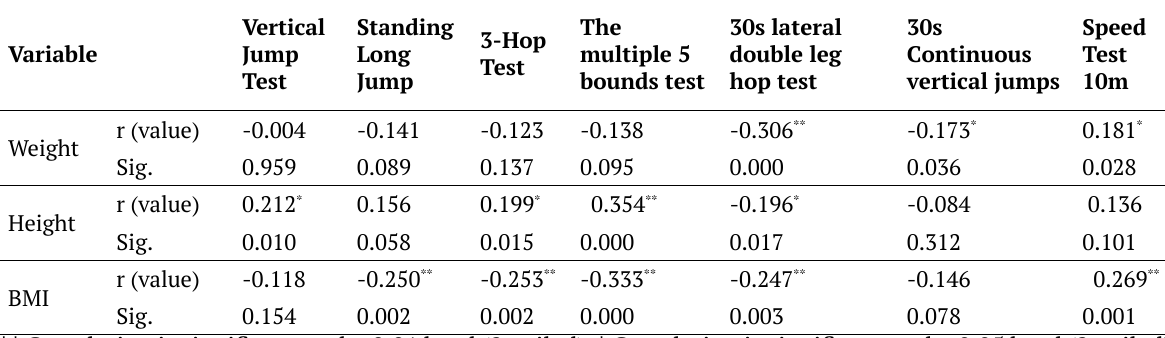
Table 7 . The value of the Pearson correlation coefficients between anthropometric indicators and lower